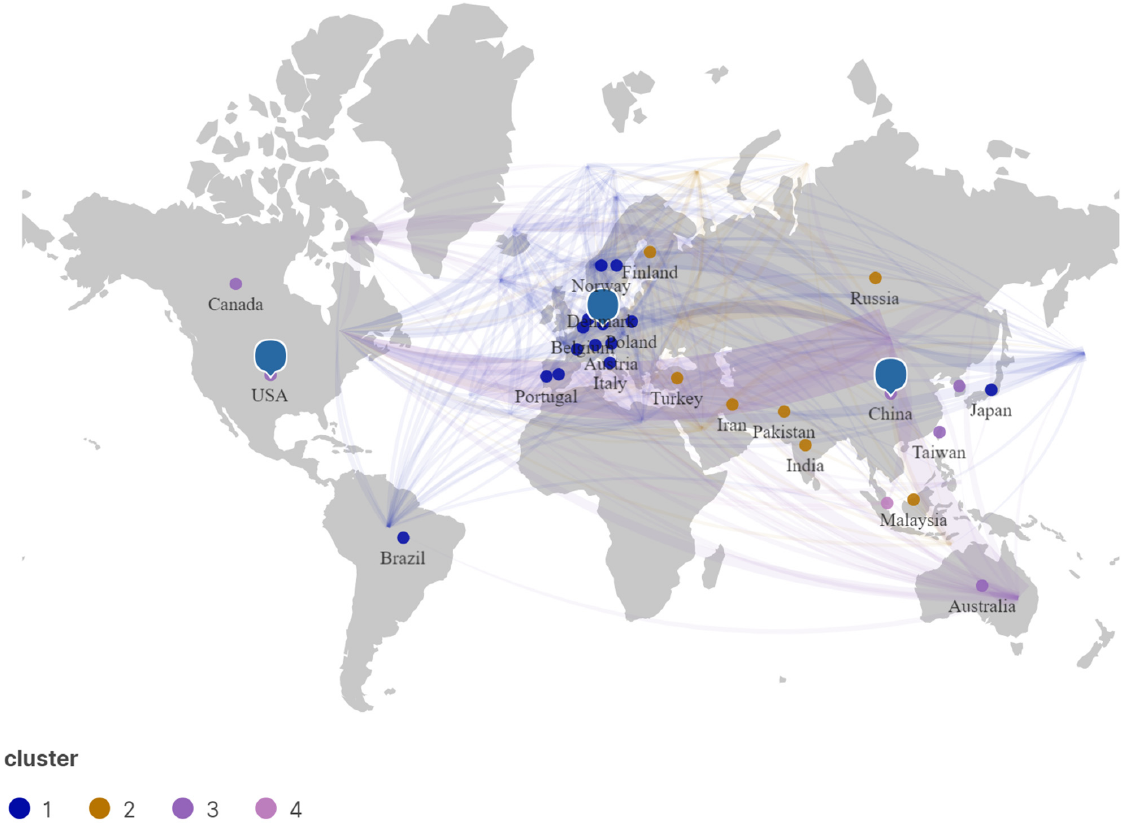
Figure 4. Cooperation between major countries and regions (the blue symbols are the positions of top 3 countries, which are China, USA and Germany).